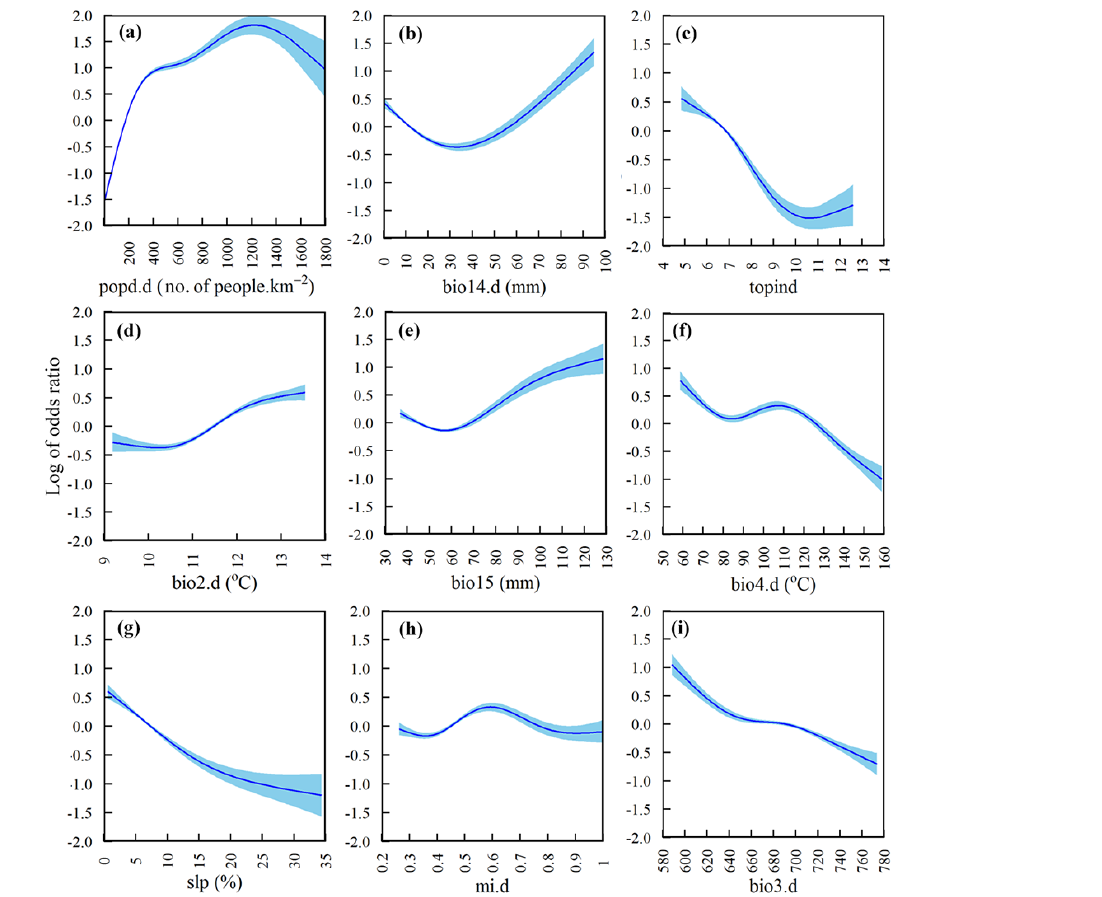
Figure 7. Partial functional plots relating the proportion (probability) of agriculture expressed as the log of odds ratio with (a) population density (popd.d), (b) precipitation of driest month (bio14.d), (c) topographic wetness index (topind), (d) mean diurnal range (bio2.d), (e) pre- cipitation seasonality (bio15), (f) temperature seasonality (bio4.d), (g) slope (slp), (h) moisture index (mi.d), and isothermality (bio3.d). The probabilities are defined using a logistic model with cubic smoothing splines ( N =